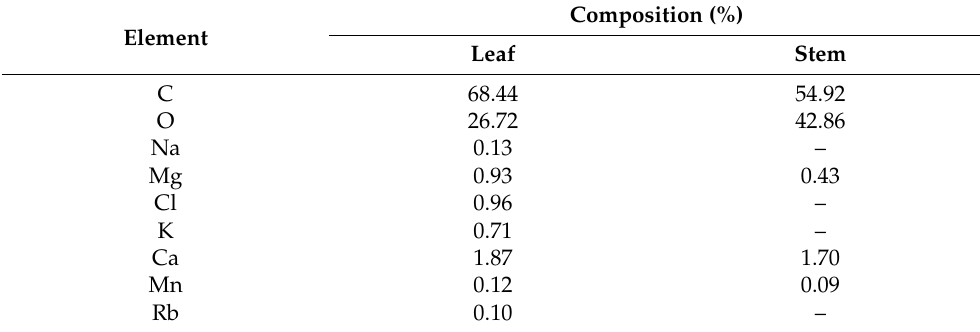
Table 4. Elemental composition (%) of powdered leaf and stem samples of Combretum molle .